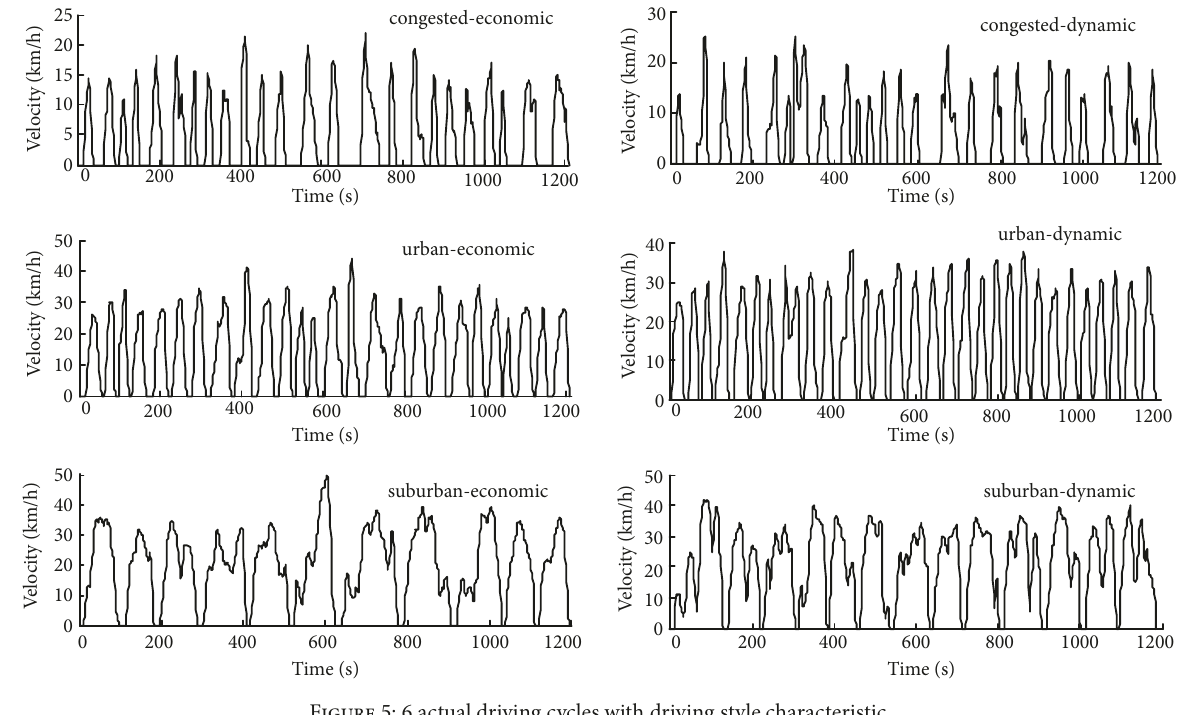
Figure 5: 6 actual driving cycles with driving style characteristic.